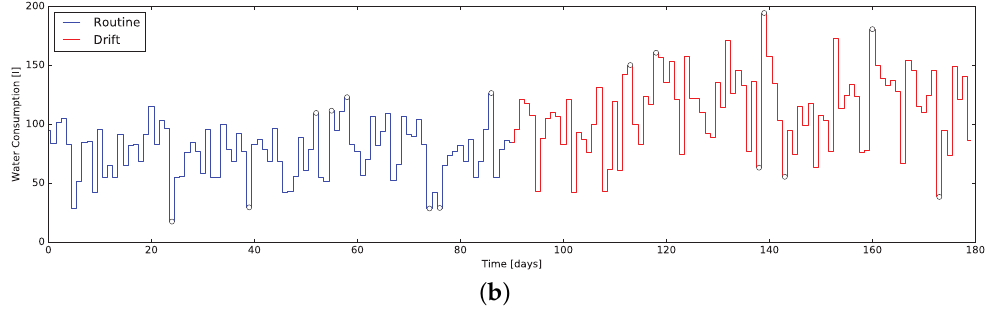
Figure 7. Results of the σ Q -test on ( a ) SAT for the bed sensor; and ( b ) RC for the water. The unexpected events are flagged with circles: white markers represent warnings , while black alarms . It is evident how abrupt changes are flagged correctly with markers, which tend to be more frequent after the induced change in routine, while the behavioral drift happens.